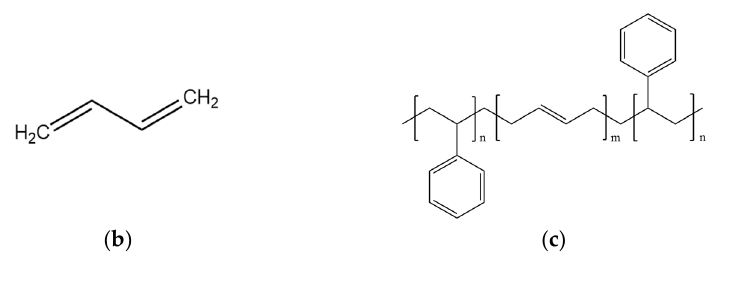
Figure 5. Molecular Structure. ( a ) Styrene. ( b ) Butadiene. ( c ) SBS.